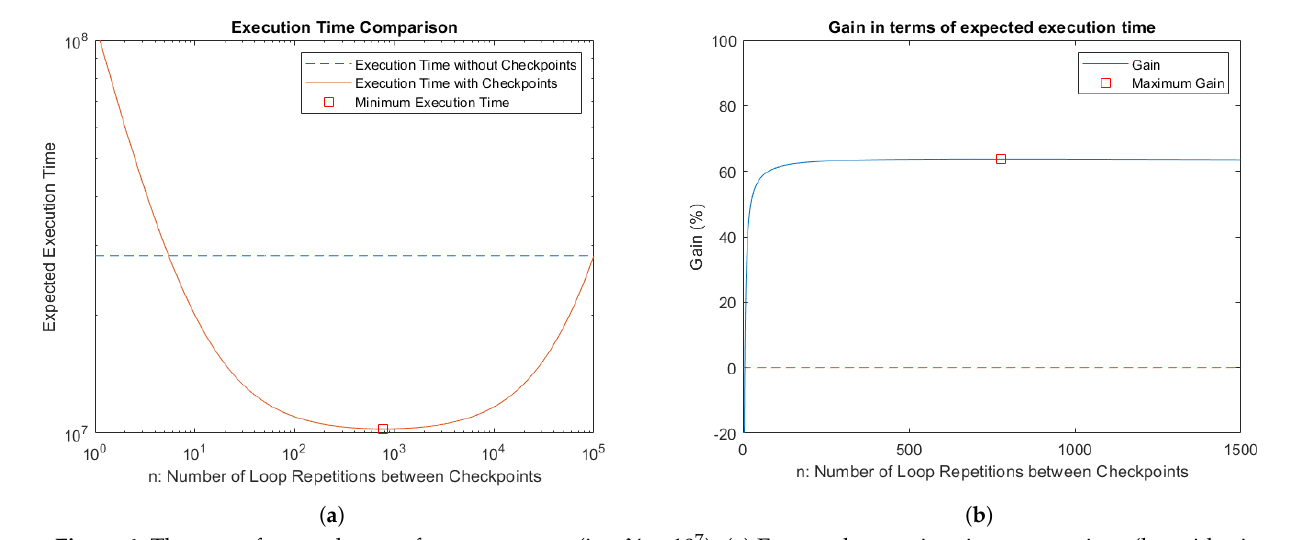
Figure 4. The case of a very large software program (i.e., Y = 10 7 ): ( a ) Expected execution time comparison (logarithmic axes) ( b ) Expected execution time gain.